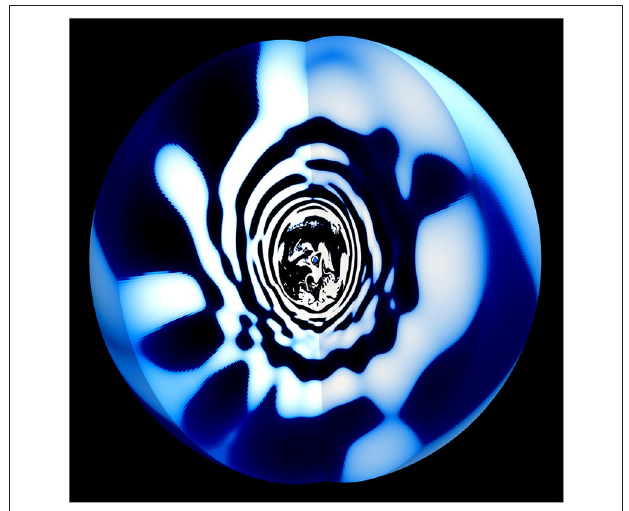
FIGURE 6 | Snapshot of a non-rotating 3D numerical simulation of gravity waves excited by core convection inside a main-sequence massive star, with a white-blue color scale indicating temperature fluctuations. Simulation courtesy of Edelmann et al.